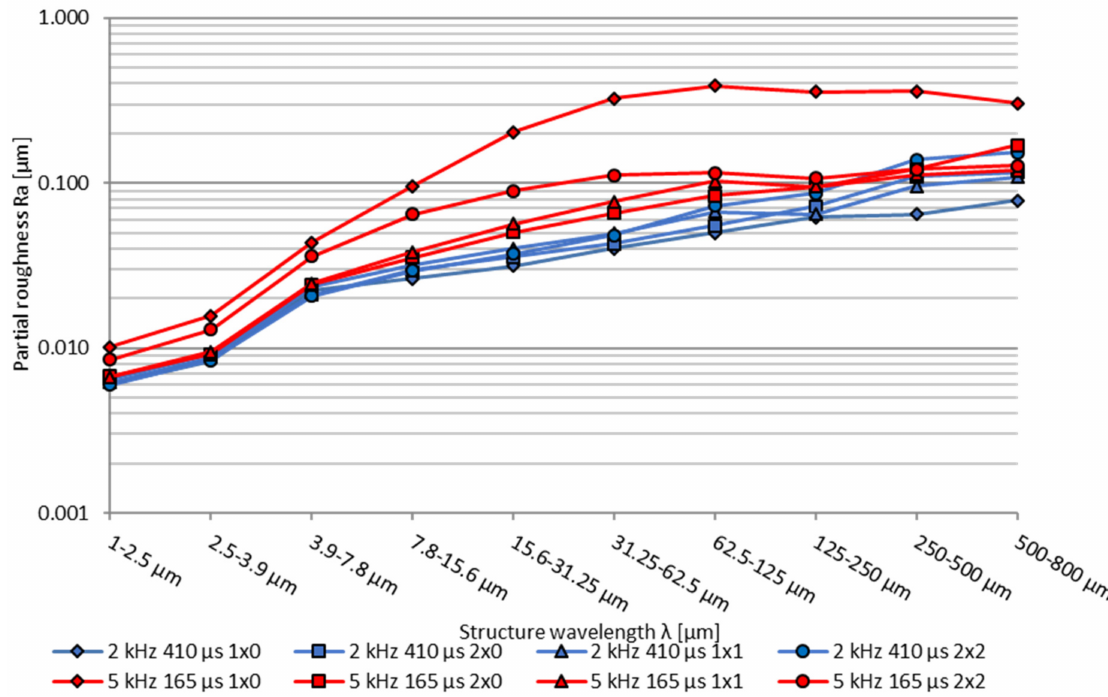
Figure 21. Partial roughness Ra with f m = 2 kHz, t m = 410 µ s and f m = 5 kHz, t m = 165 µ s depending on the number of polishing passes, measured in